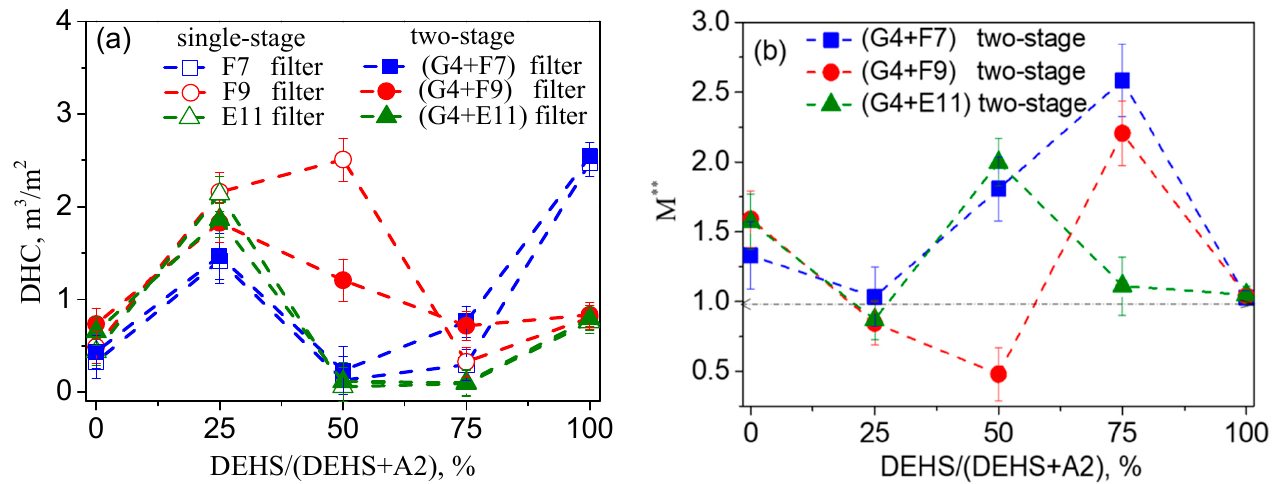
Figure 13. ( a ) DHC and ( b ) M** profiles in the designated three two-stage filtration configurations when loaded with varied oil–solid mixed particles.